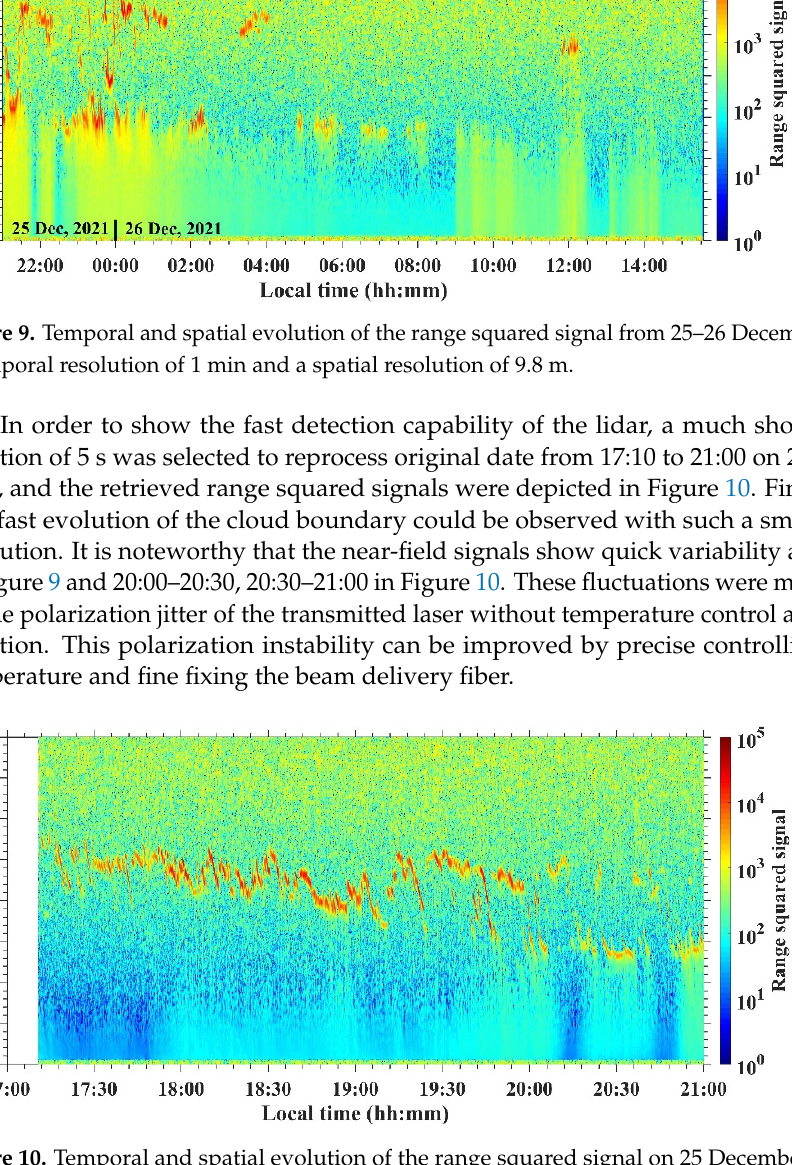
Figure 10. Temporal and spatial evolution of the range squared signal on 25 December 2021 with a temporal resolution of 5 s and a spatial resolution of 9.8 m.